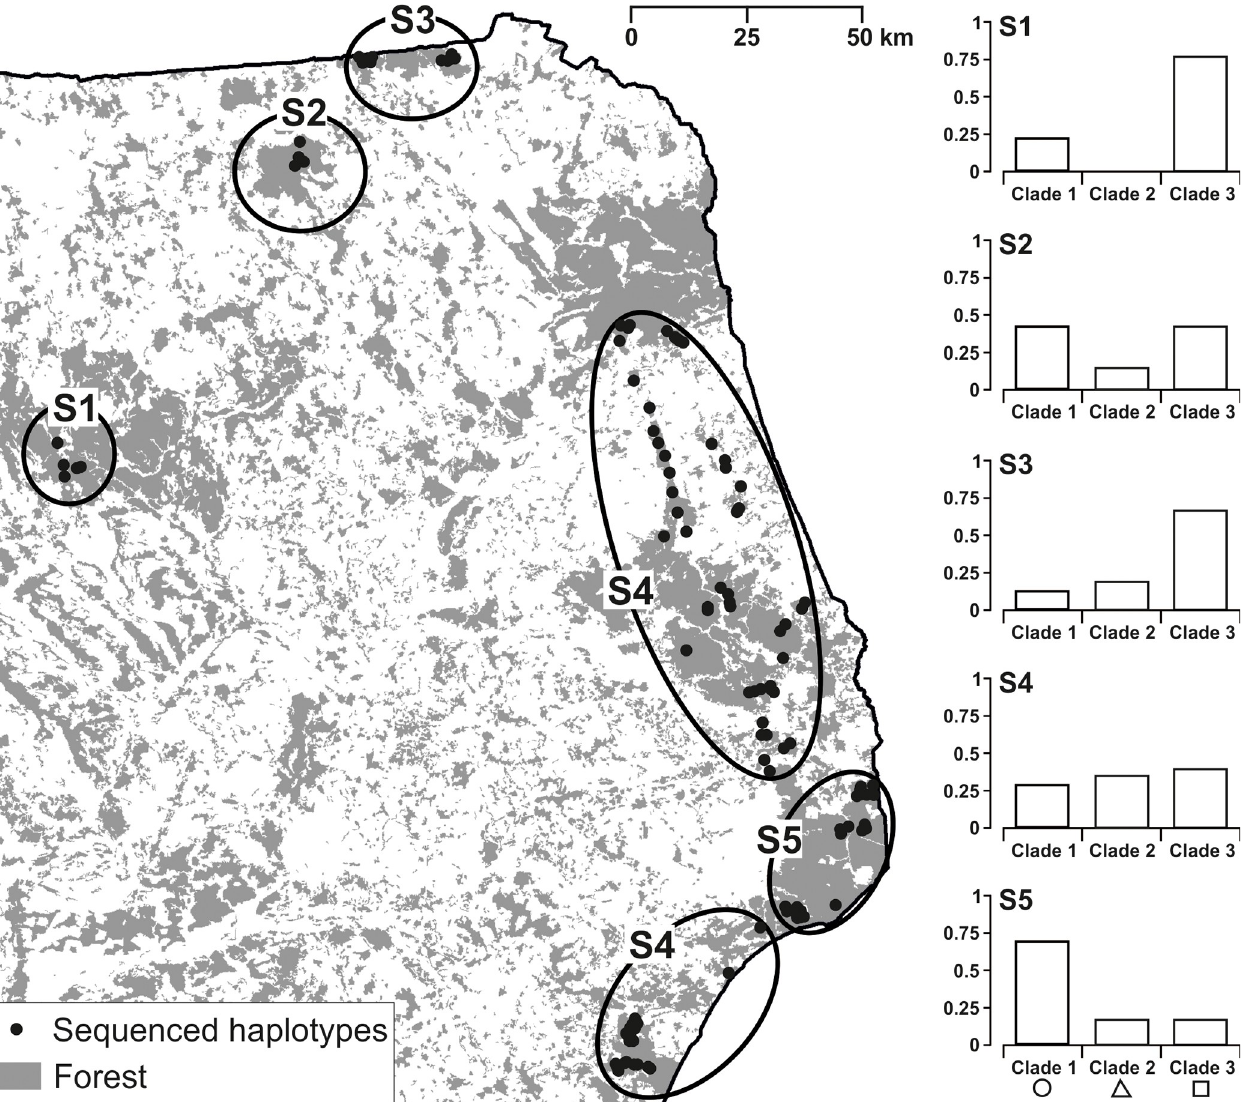
Fig 5. Five subpopulations (S1–S5) of yellow-necked mouse in north-eastern Poland, based on mtDNA haplotype frequency, delimited by SAMOVA (left panel). Proportions of mtDNA haplogroups (clades) in each of the defined subpopulation (right panel). Black points refer to trapping sites.